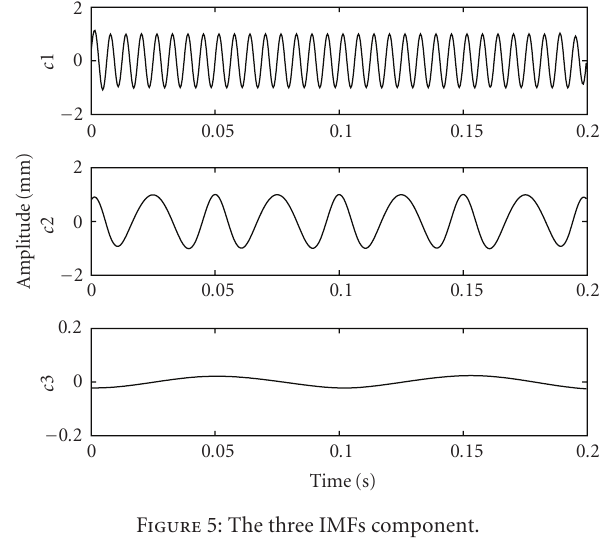
Figure 5: The three IMFs component.